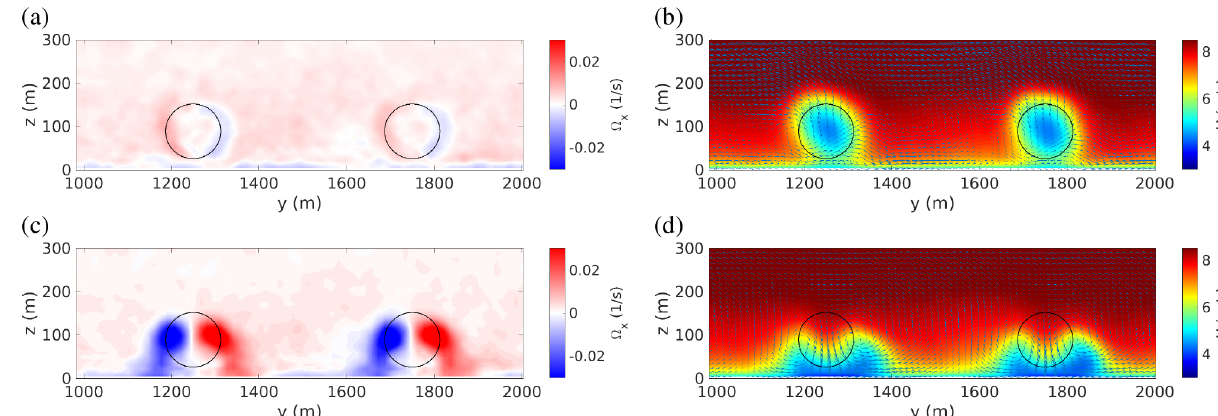
Figure B1. Tilt control: cross-stream view of the mean streamwise vorticity and velocity fields obtained by using the ADMC turbine model = 1 . 5 with no tilt or yaw (a, b) and with upwind turbines tilted by ϕ = 30 ◦ and in the baseline case, where all turbines are operated at C (cid:48) T = 3 (c, d) . The streamwise vorticity fields (a, c) are extracted 3 D downstream of the first turbine row, while the streamwise operated at C (cid:48) T velocity fields (b, d) are extracted D/ 2 upstream of the second row of